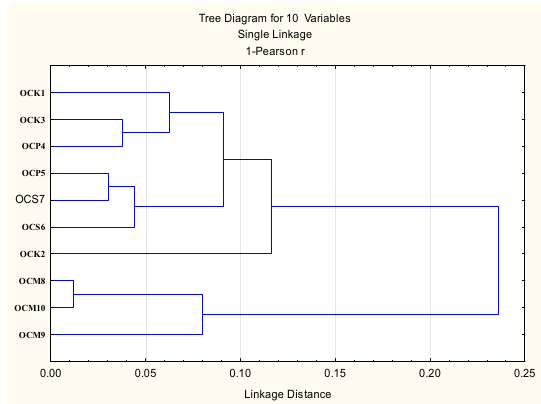
Figure 1. Bidimensional dendrogram representing the similarity in the main components of the essential oils, between 10 harvests of 4 basil varieties growing in the greenhouse conditions.